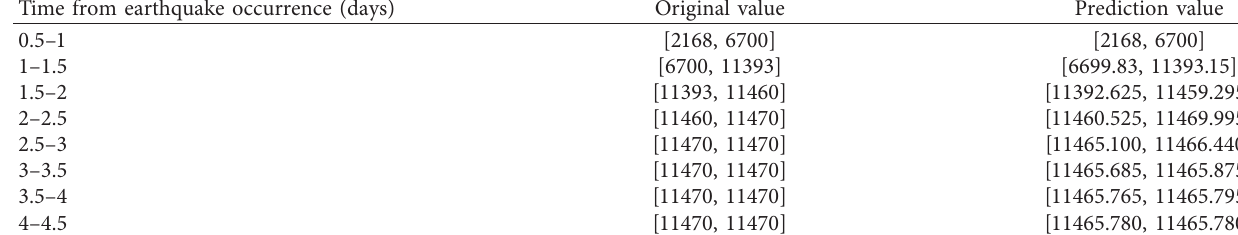
Table 4: Simulation results.